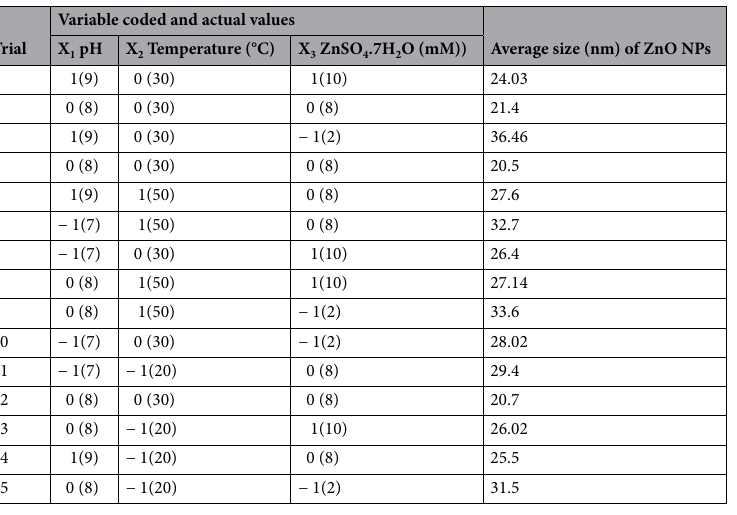
Table 1. Design matrix of Box–Behnken experiments showing coded and actual values of the evaluated independent variables along with response.